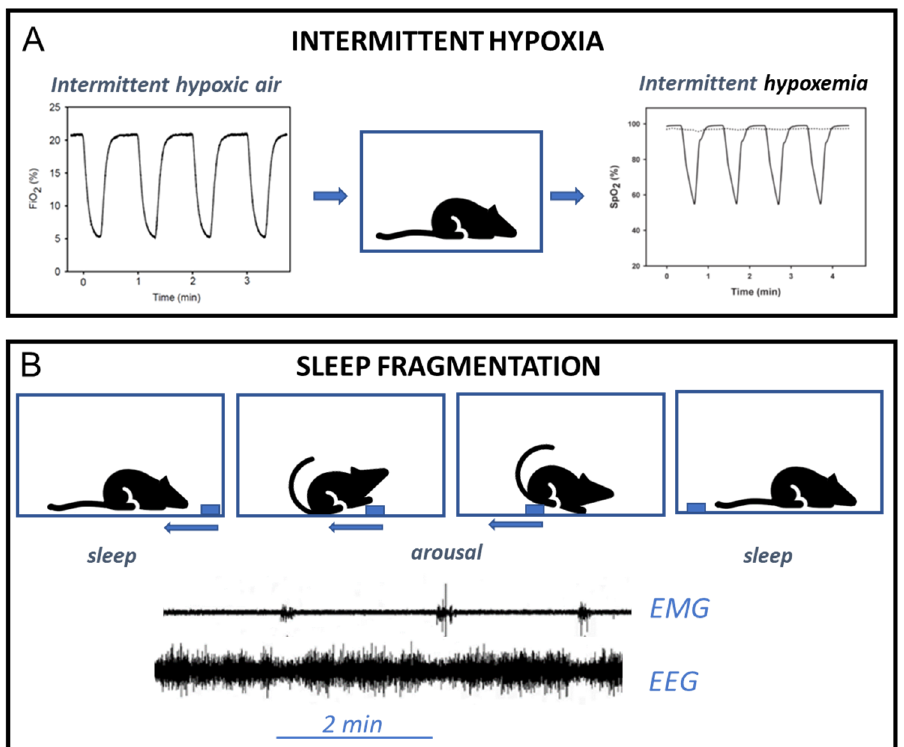
Figure 3. Diagrams of the most common experimental animal models of sleep apnea. ( A ) Application of intermittent hypoxia: air with cyclic O 2 fraction (FiO 2 ) in the animal cage induces recurrent hypoxemia (SaO 2 ). ( B ) Induction of sleep fragmentation: smooth cyclic movement of a bar (blue) in the cage ground induces cyclic arousal, as reflected by electromyography (EMG) and electroencephalography (EEG) signals in the mice. See text for explanation. Reprinted from Ref. [6]. Creative Commons License.